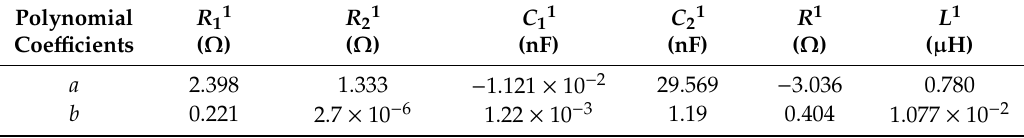
Table 4. Linear parameters for MT1 pi-circuit as a function of soil resistivity.